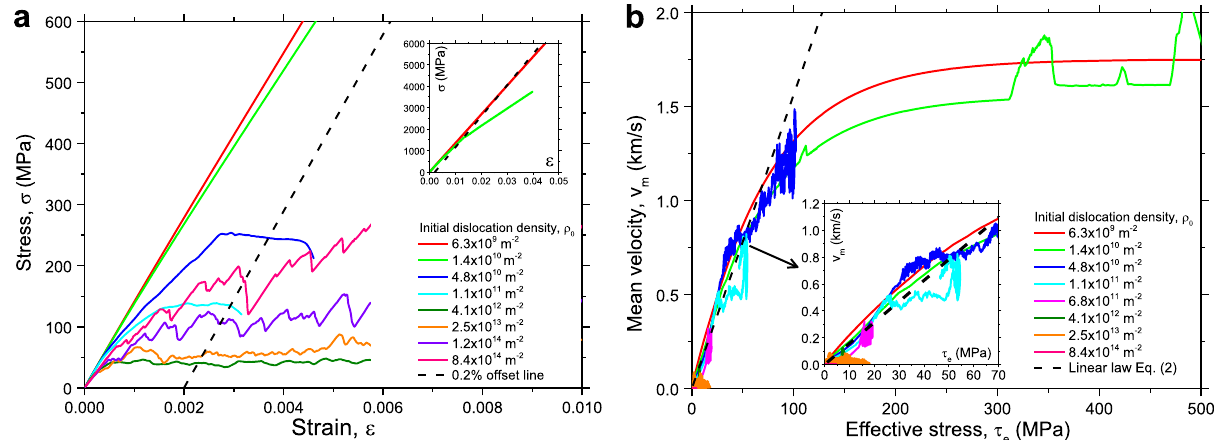
Fig. 2 Stress – strain curves and mean dislocation velocity predicted from current DDD simulations. a Stress – strain curves at applied strain rate of 10 4 s − 1 and different initial dislocation densities. b Mean velocity of dislocations on active slip systems versus effective stress at applied strain rate of 10 4 s − 1 and different initial dislocation densities. DDD is abbreviation of discrete dislocation